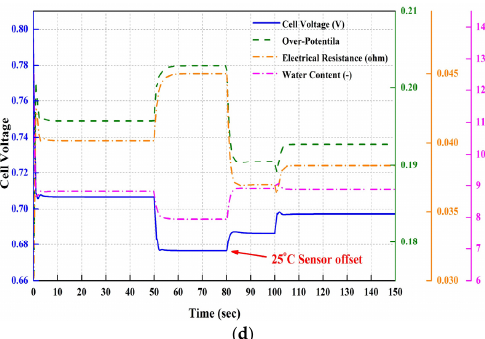
Figure 6. Transient sensor fault behavior in PEM fuel cell under sudden stack sensor scaling (( a ) Temperature of stack and coolant inlet, ( b ) cooling components, ( c ) heat rejection in stack, ( d ) voltage responses).